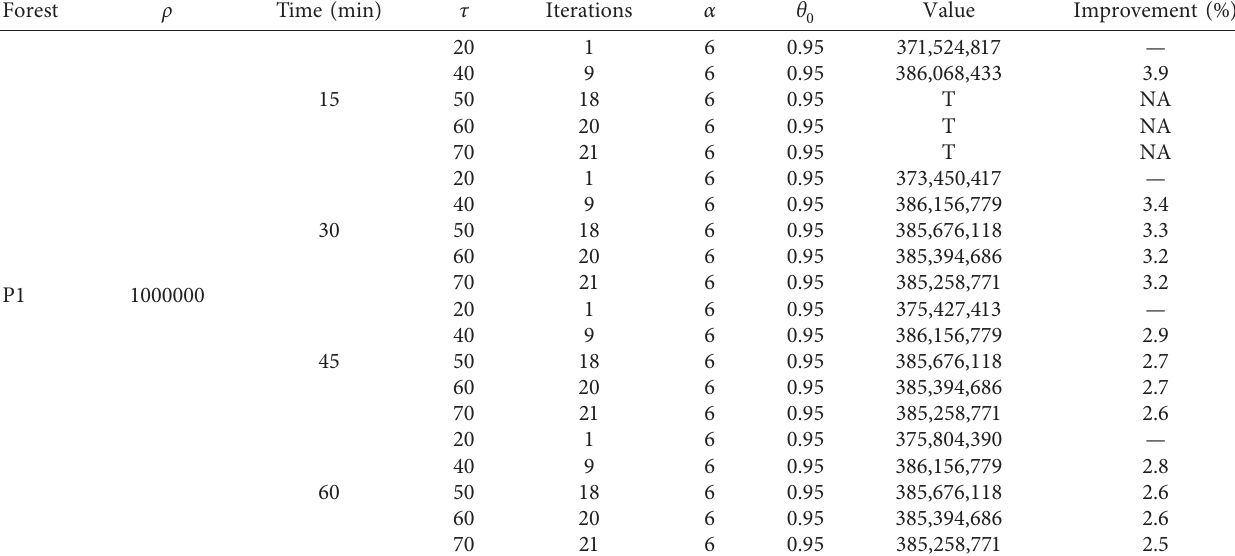
Table 4: Effects of τ and allocated time for the forest P1.